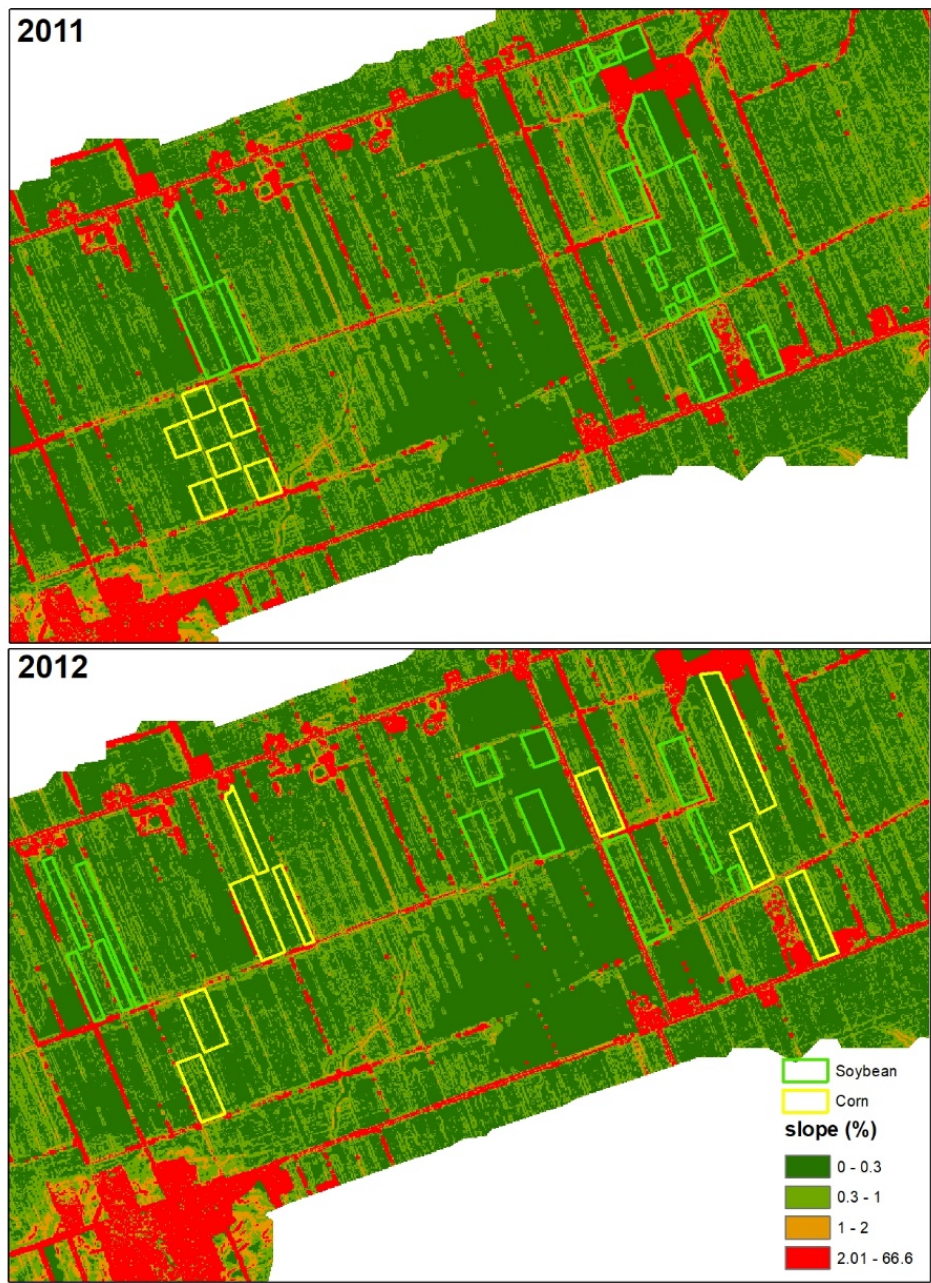
Figure 3. Slope where experimental fields were located during 2011 and 2012. The flow accumulation variable was calculated as the number of cells that flowed into each downslope cell (Figure 4). Higher relative flow accumulation numbers indicate areas of concentrated flow and can be used to determine stream channels, swales or depressions. Cells with a value of 0 indicate local topographic highs with no upstream catchment area, such as knolls and ridges (see https: // pro.arcgis.com / en / pro-app / tool-reference /